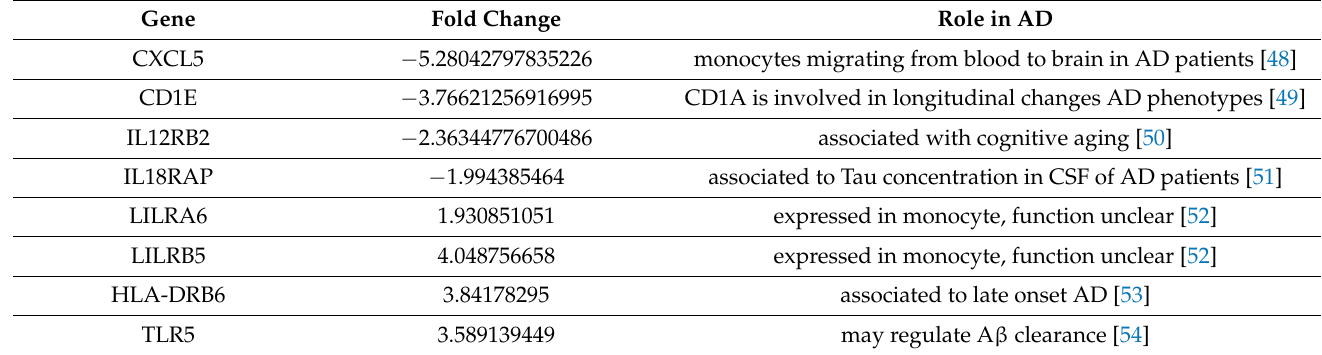
Table 2. Most deregulated genes identified between AD-NT and CTR-NT and their suggested roles in AD.